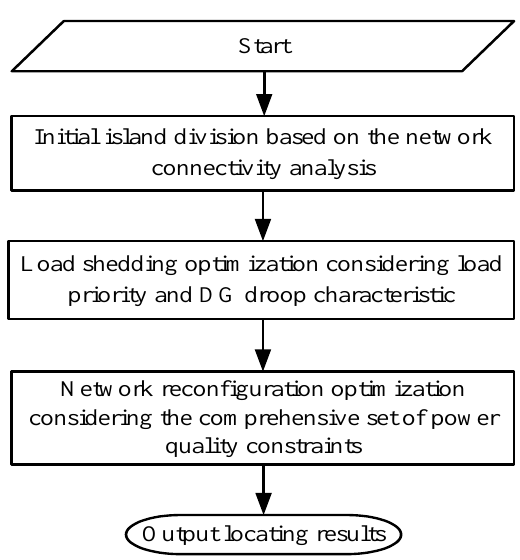
Figure 1. Framework of the proposed self-healing recovery strategy. 96